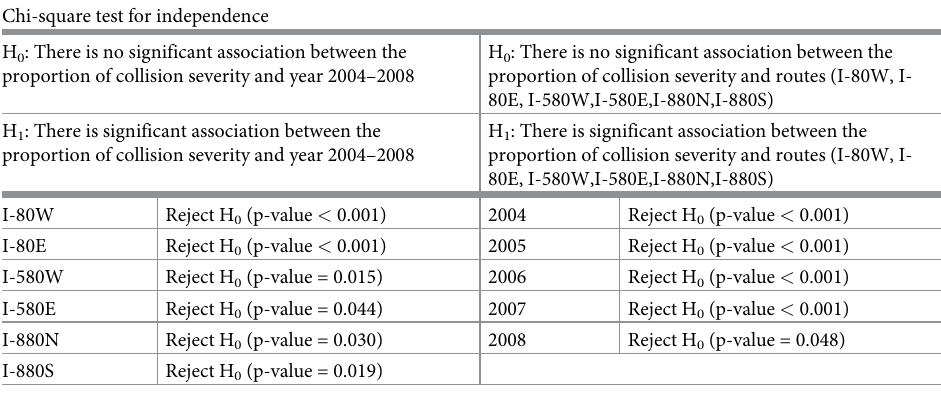
Table 2. Statistical test results for the proportions of collision severity levels over years and routes. Chi-square test for